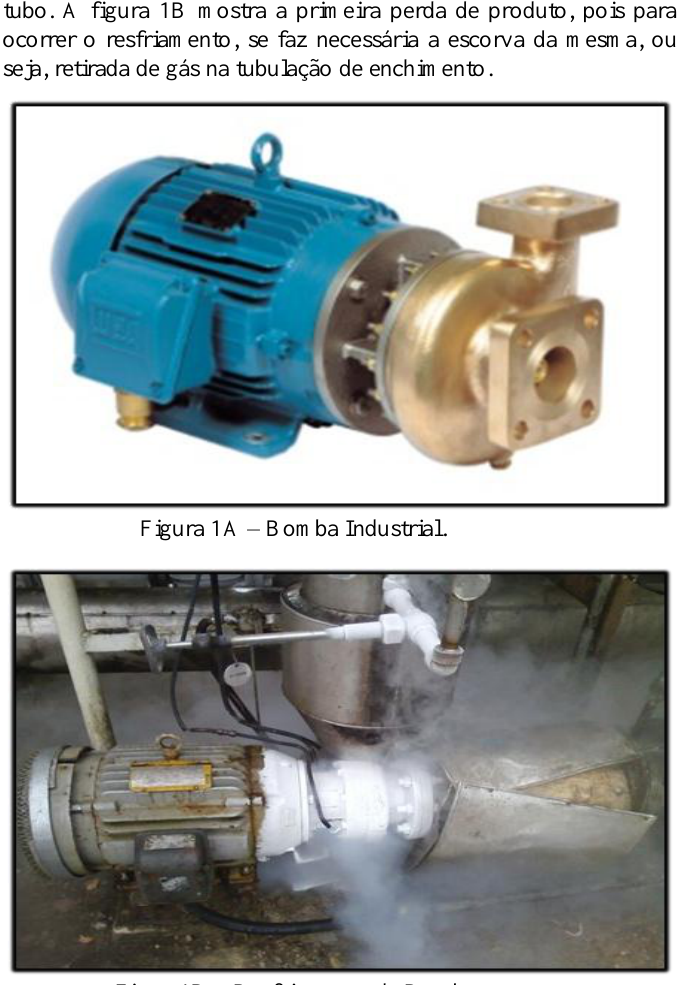
Figura1B – Resfriamento da